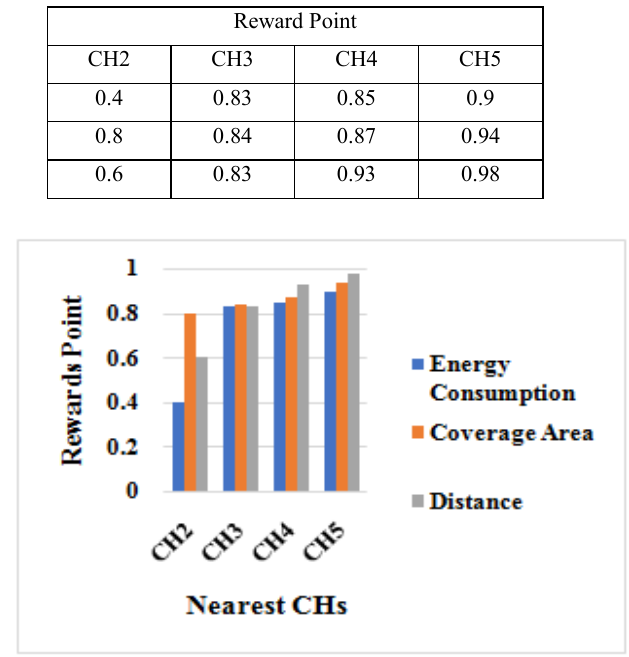
Table 6. Reward Point for Scenario-1